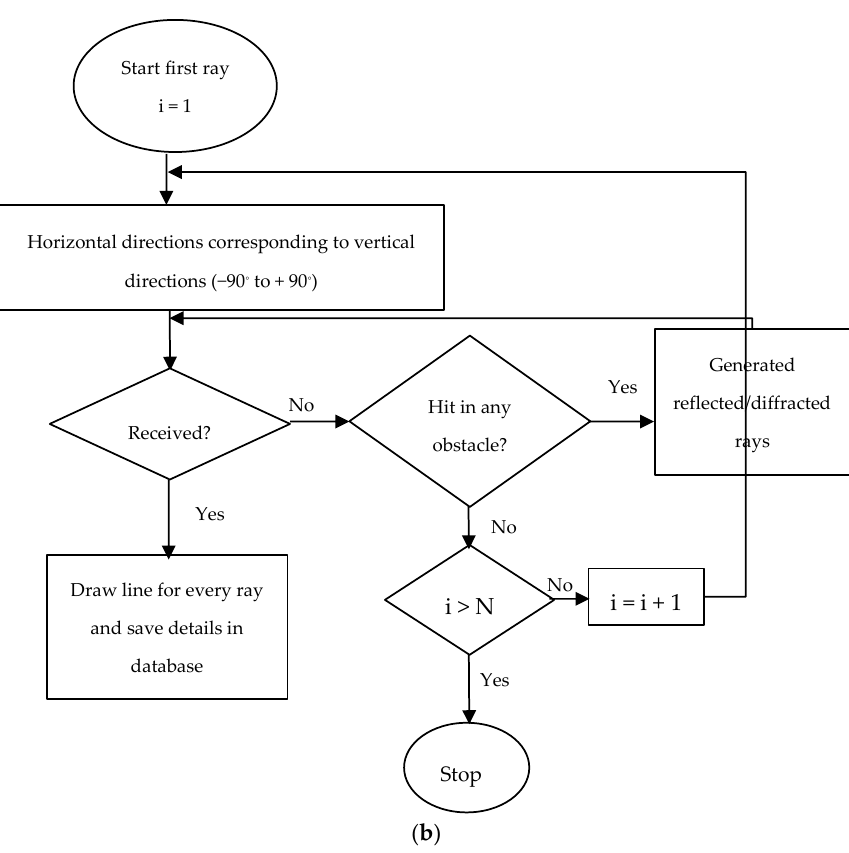
Figure 2. Workflow of ( a ) proposed RT method and ( b ) SBRT method.